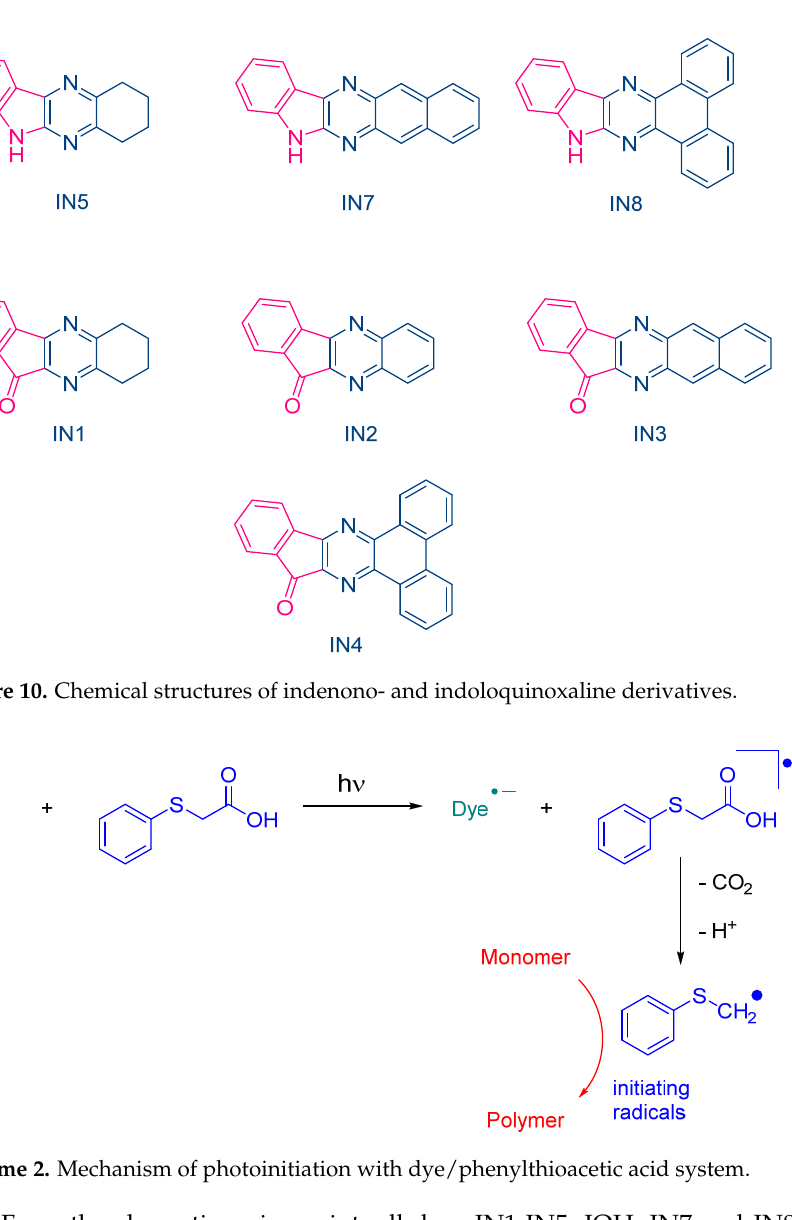
Table 3. Optical characteristics of IN1-IN5, IQH, IN7, IN8 and camphorquinone (CQ) in ethanol.